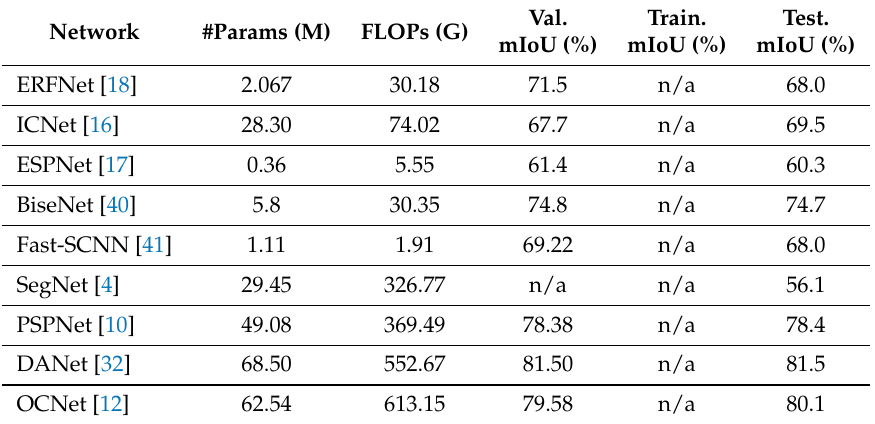
Table 3. Results of numerous current state-of-the-art